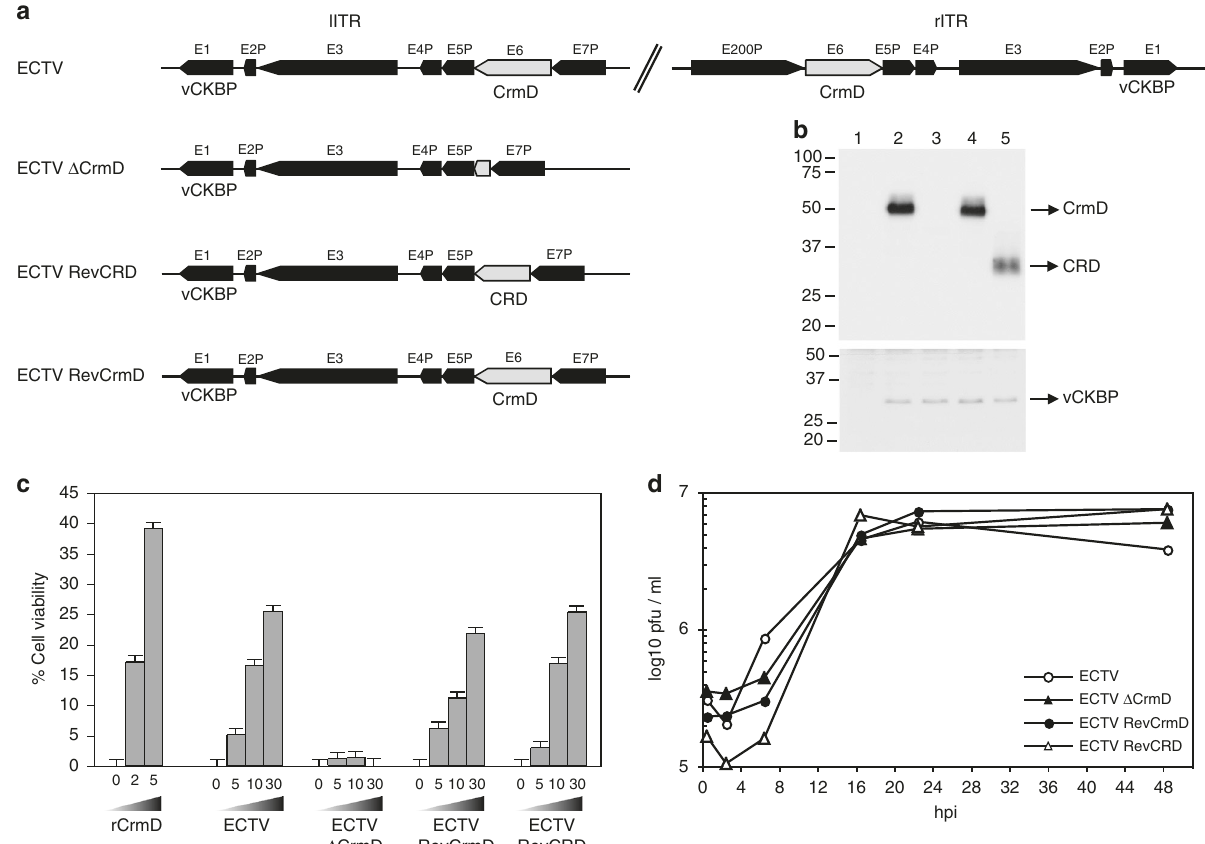
Fig. 1 ECTV CrmD recombinant viruses. a Schematic diagram of the genomic structure of the recombinant ECTVs generated for the study of the role of ECTV CrmD in mousepox pathogenesis. The names of the genes fl anking the CrmD locus are indicated. In gray, the CrmD locus in the parental and recombinant viruses is shown. Both left inverted terminal repeat (lITR) and right inverted terminal repeat (rITR) are represented for ECTV, whereas the lITR is shown for the other viruses. b Western blot analyses using anti-CrmD and anti-35-kDa vCKBP antisera of supernatants from BSC-1 cells that were mock- infected (1) or infected with ECTV (2), ECTV Δ CrmD (3), ECTVRevCrmD (4) or ECTVRevCRD (5) at a multiplicity of infection of 5 PFU/cell and harvested at 24 h post-infection. The position of the respective proteins is indicated by arrows. Molecular size markers in kDa are shown on the left. c TNF-induced cytotoxicity assay. Increasing amounts of recombinant ECTV CrmD (rCrmD, in μ g/ml) or supernatants (equivalent to 5, 10 or 30 × 10 3 cells) obtained as in b were added to block the effect of TNF on L929 cells. The values obtained in the presence of mock-infected cell supernatants have been substracted in each case. Data are mean + / − standard error of the mean (SEM) of triplicate samples. d Single-step growth curves of the indicated viruses. BSC-1 cells were infected with 5 PFU/cell and the virus production was titrated at the indicated hour post-infection. The means of duplicate samples are